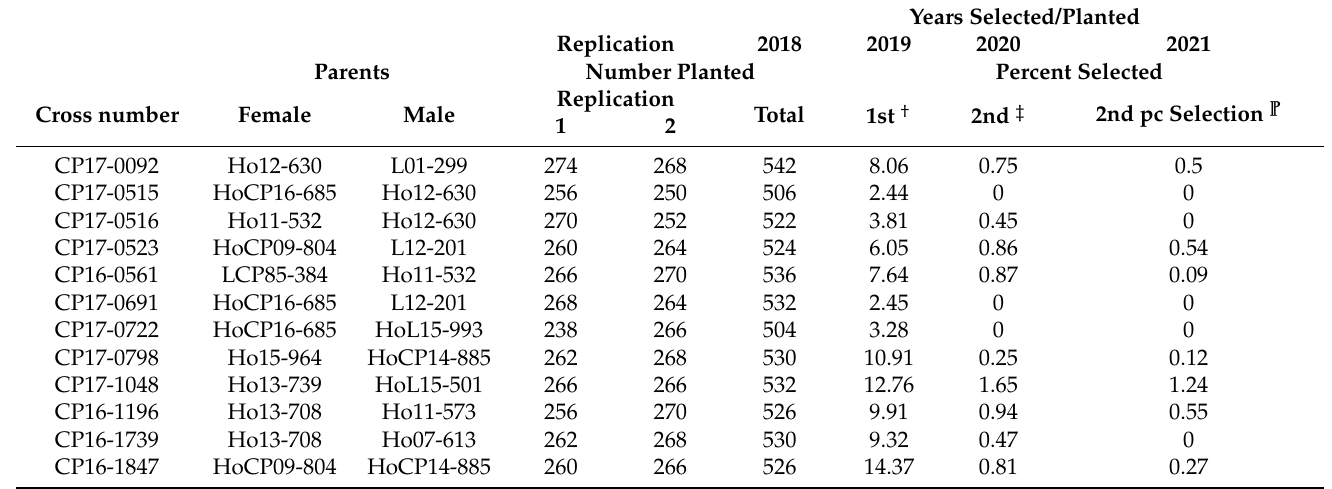
Table 1. Cross number, parents, number of seedlings and percent selection in first line, second line and second line first ratoon.